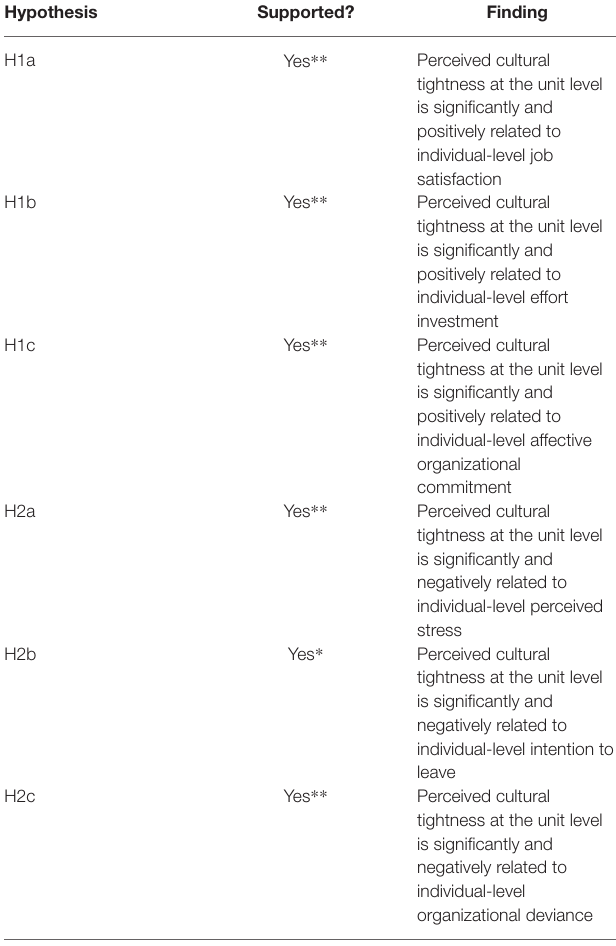
TABLE 2 | Summary of hypothesis